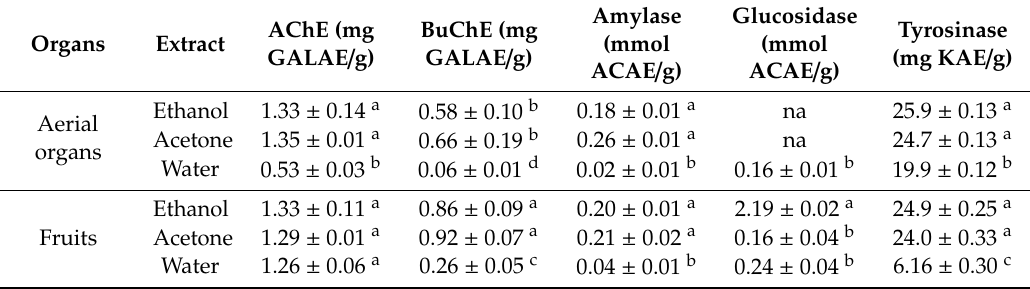
Table 4. Enzymatic inhibitory activity on acetyl- (AChE), butyrylcholinesterase (BuChE), α -glucosidase, α -amilase and tyrosinase, of di ff erent extracts prepared from aerial vegetative organs and fruits of